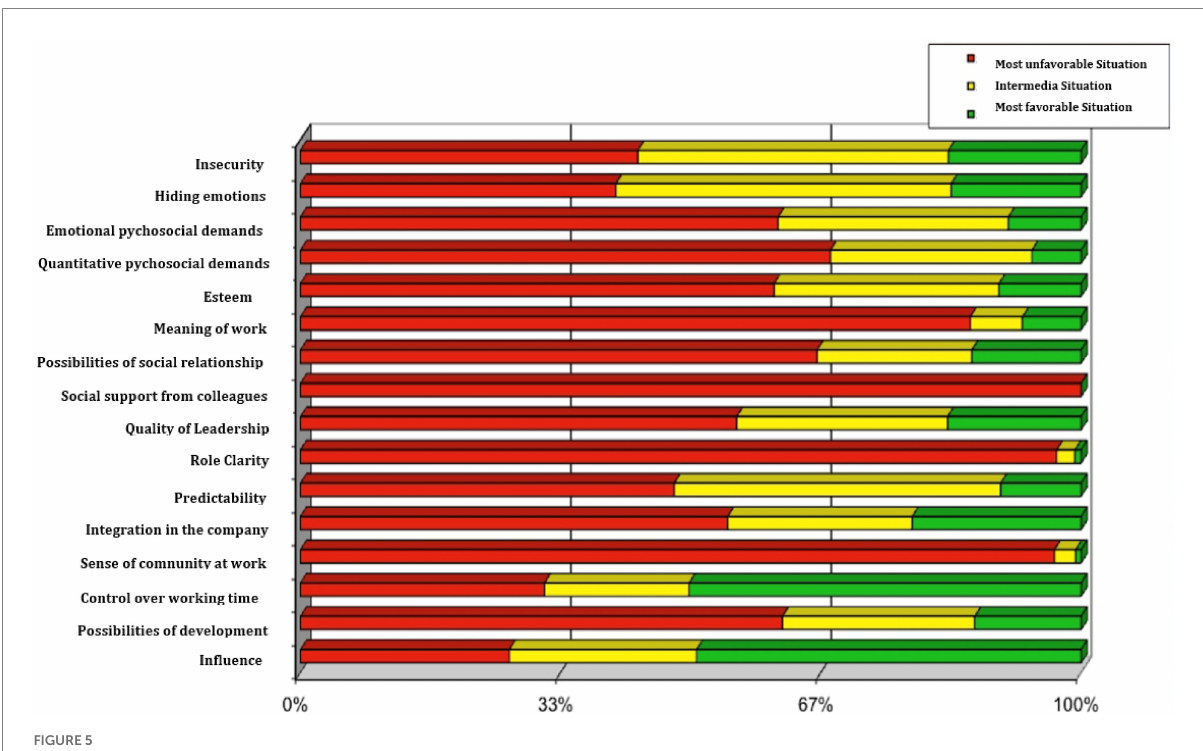
FIGURE 5 Level of psychosocial risk of professional